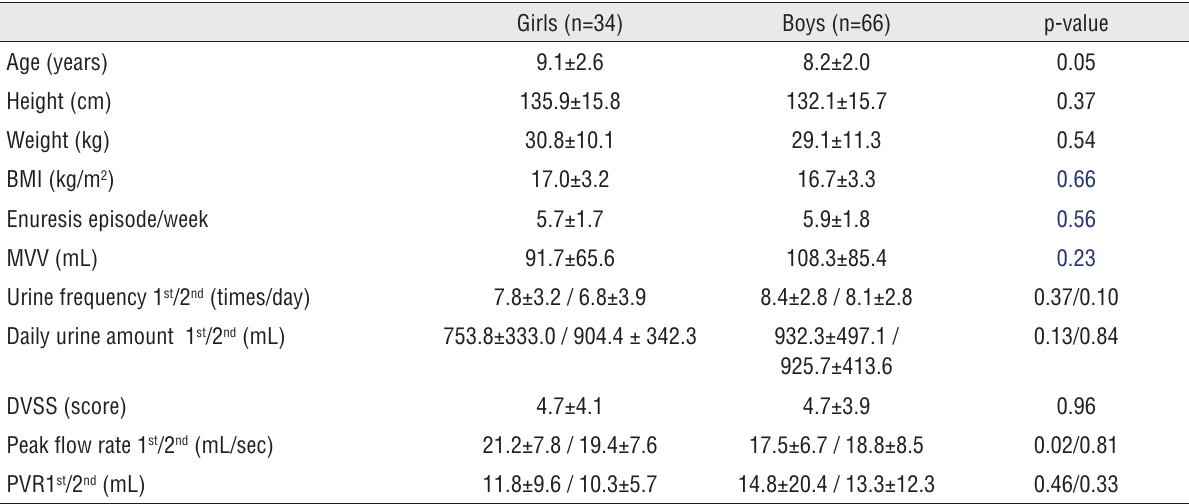
Table 1 - Baseline characteristics of the enrolled